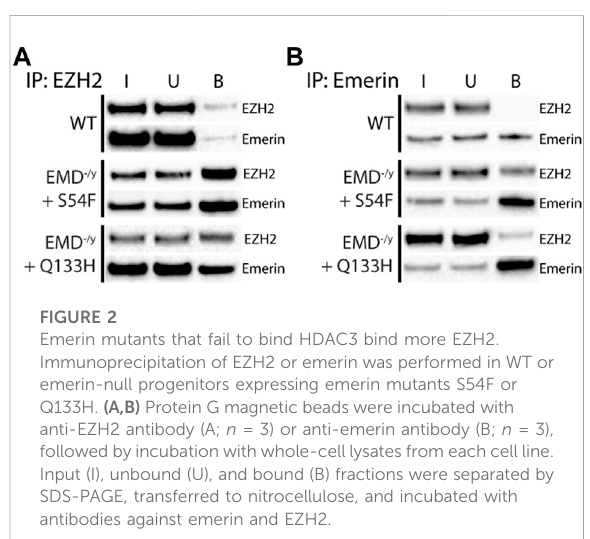
FIGURE 2 Emerin mutants that fail to bind HDAC3 bind more EZH2. Immunoprecipitation of EZH2 or emerin was performed in WT or emerin-null progenitors expressing emerin mutants S54F or Q133H. (A,B) Protein G magnetic beads were incubated with anti-EZH2 antibody (A; n = 3) or anti-emerin antibody (B; n = 3), followed by incubation with whole-cell lysates from each cell line. Input (I), unbound (U), and bound (B) fractions were separated by SDS-PAGE, transferred to nitrocellulose, and incubated with antibodies against emerin and